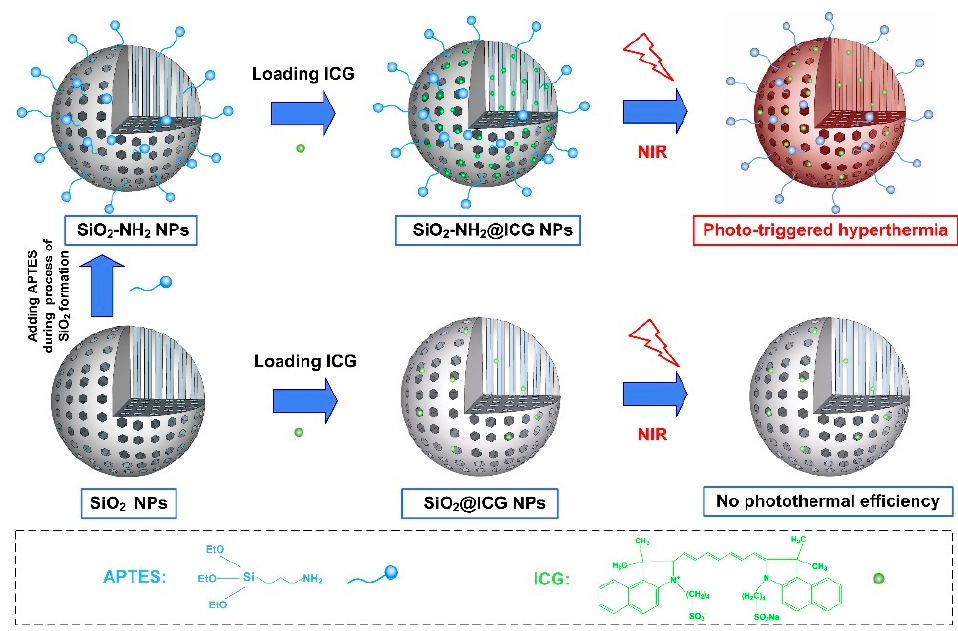
Figure 1. Schematic view of the synthesis procedure of amino group modified SiO 2 NPs loading with ICG and the NIR-triggered hyperthermia performance.